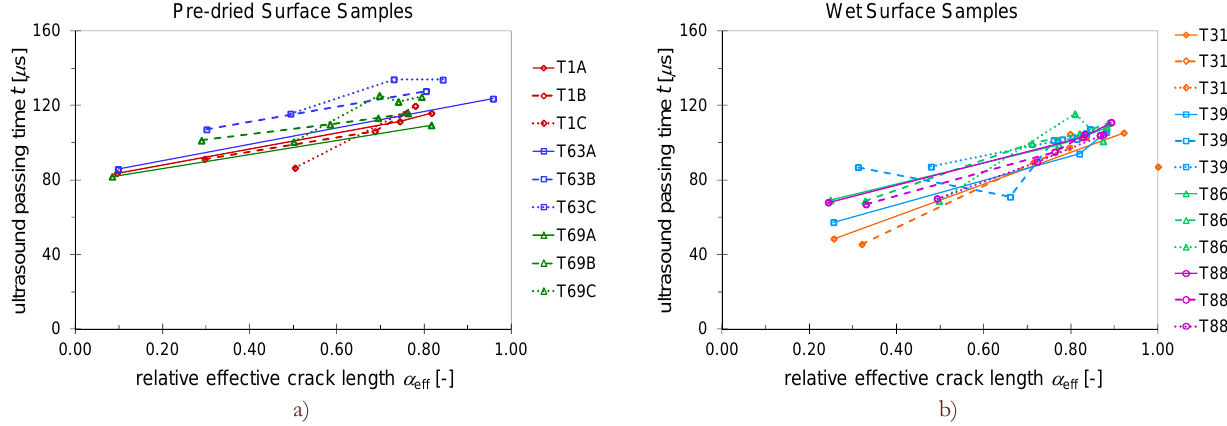
Figure 6: Relationship between the ultrasound pulse passing time, t , and the relative effective crack length,  eff , for the pre-dried (a) and the wet surface (b) samples evaluated at the notch (n)